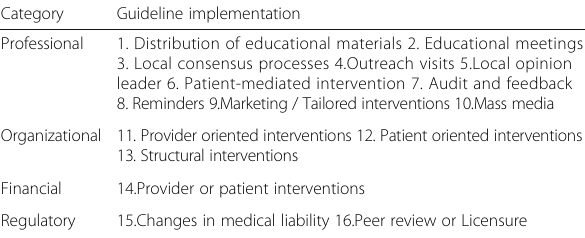
Table 18 (abstract A33). Implementation strategies used a